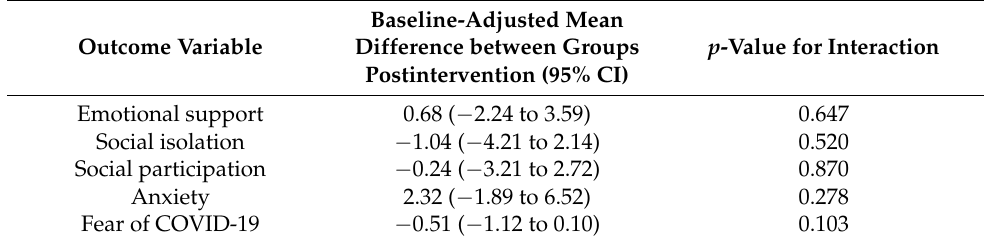
Table 4. Adjusted mean differences for the outcome measures of the intention-to-treat analysis ( n = 135). Baseline-Adjusted Outcome Variable